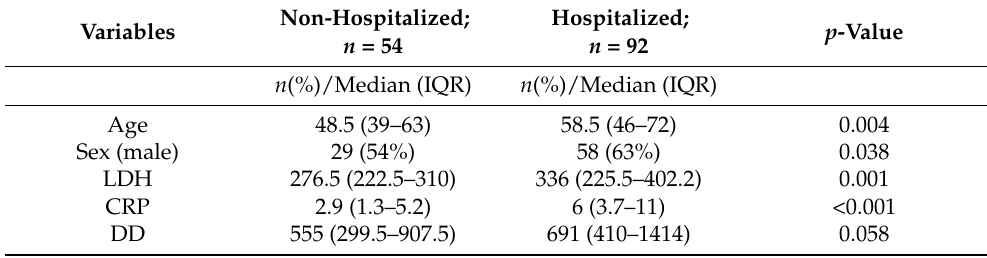
Table 1. Population characteristics of non-hospitalized and hospitalized COVID-19 patients.